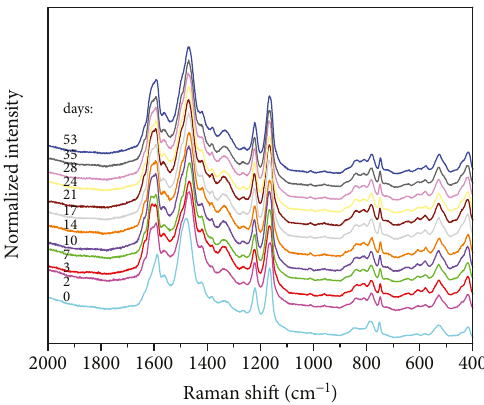
Figure 4: Raman spectra of a line burnt to the PANI-S fi lm on gold with a 0.2W 1064nm laser line at low speed, obtained with the 633nm excitation line at a marked time after burning. The samples were stored at room temperature in air.